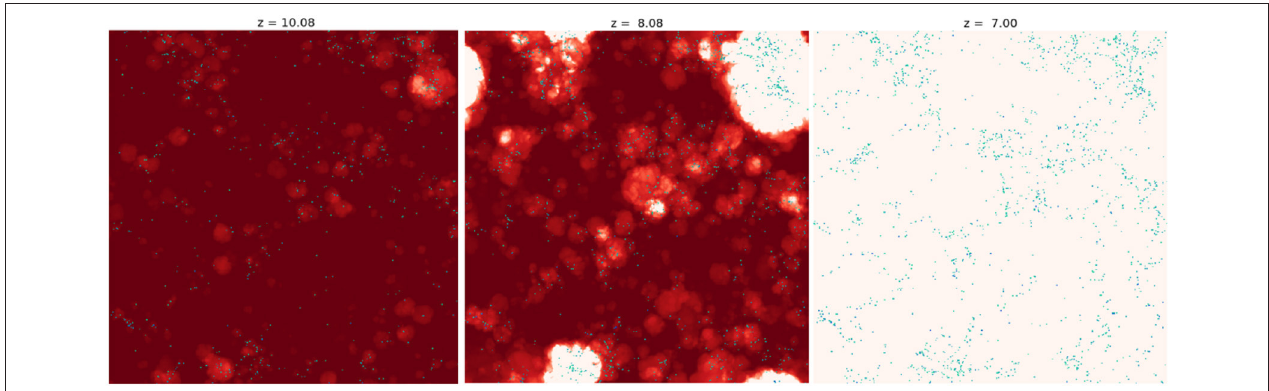
FIGURE 11 | An Enzo simulation of cosmic reionization with sufficient resolution to include the MCH halos discussed above. Halo finding is done inline with the simulation, and their ionizing emissivities are assigned based on results from the Renaissance Simulations . The intermittency of star formation in such halos results in stochastic early